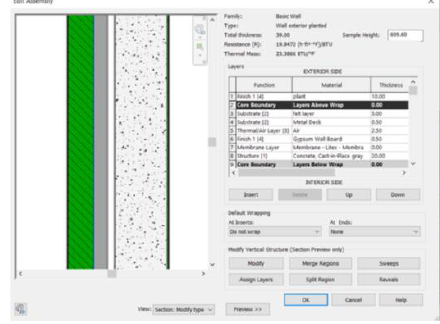
Figure 14 Living wall defined for the building with vertical green system in the Revit program